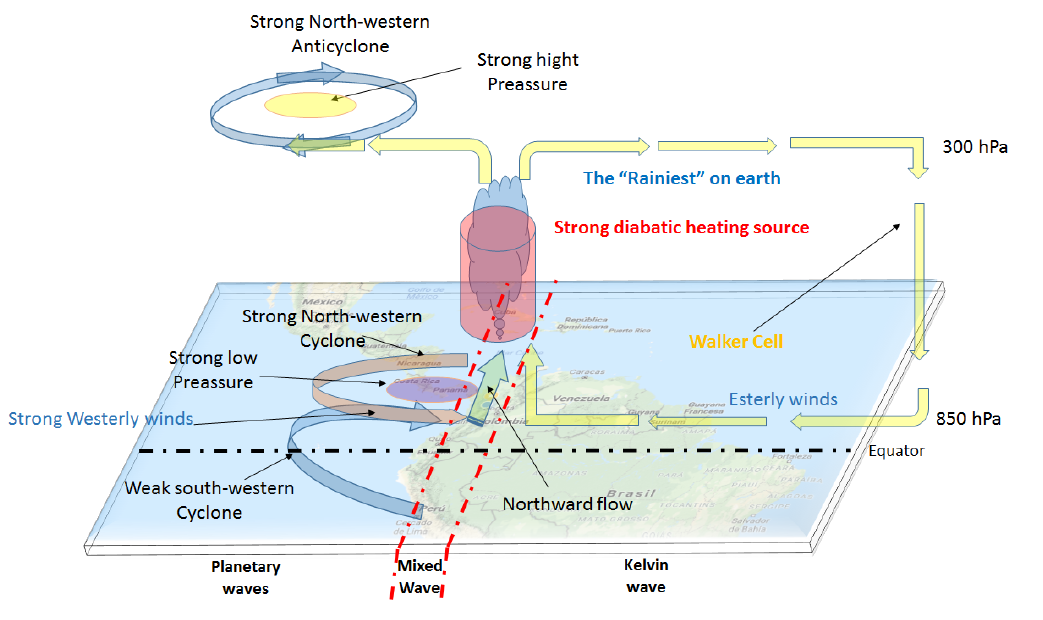
Figure 7. Conceptual scheme of the large scale circulation in northern South America and Meso-America from mid-March to mid-December according to the Matsuno-Gill